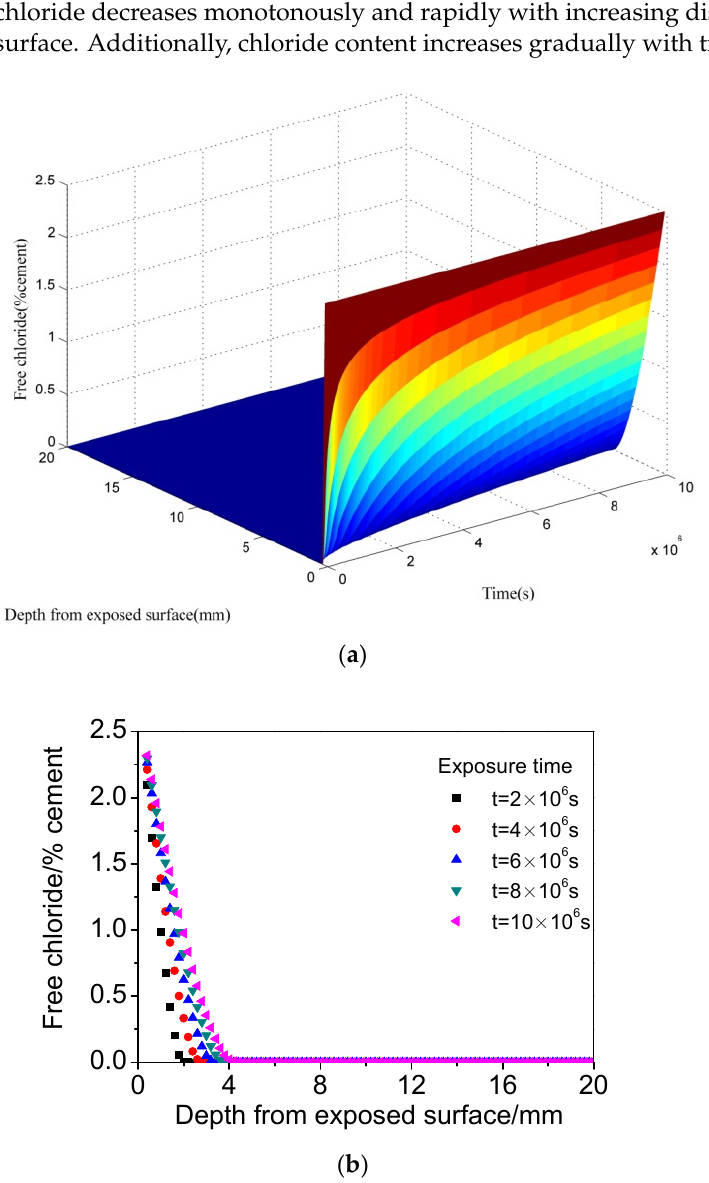
Figure 1. The calculated chloride distribution of concrete induced by diffusion. ( a ) Three dimensions. ( b ) Two dimensions.